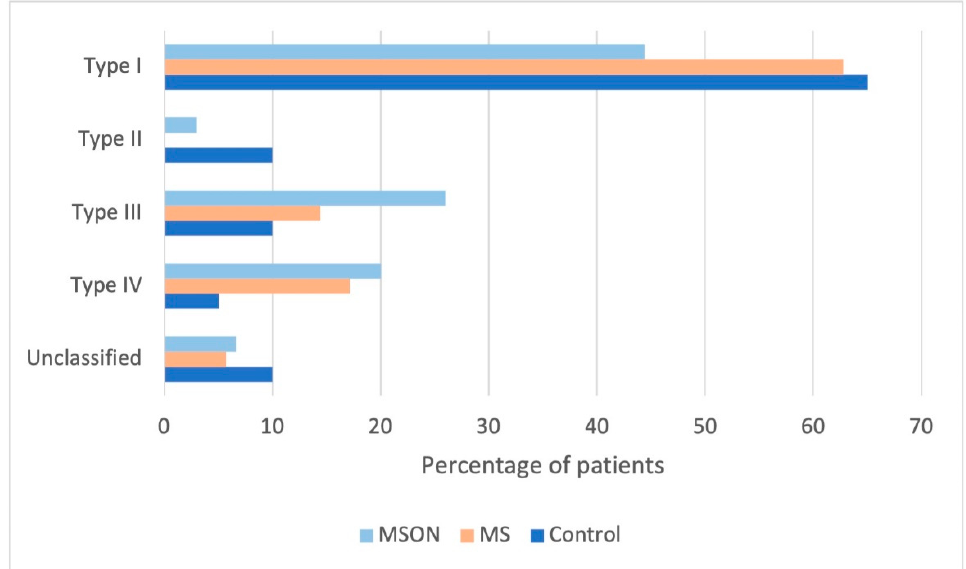
Figure 3. Percentage of the patients classified according to DEM instructions. MSON: group of multiple sclerosis with previous optic neuritis. MS: multiple sclerosis group.